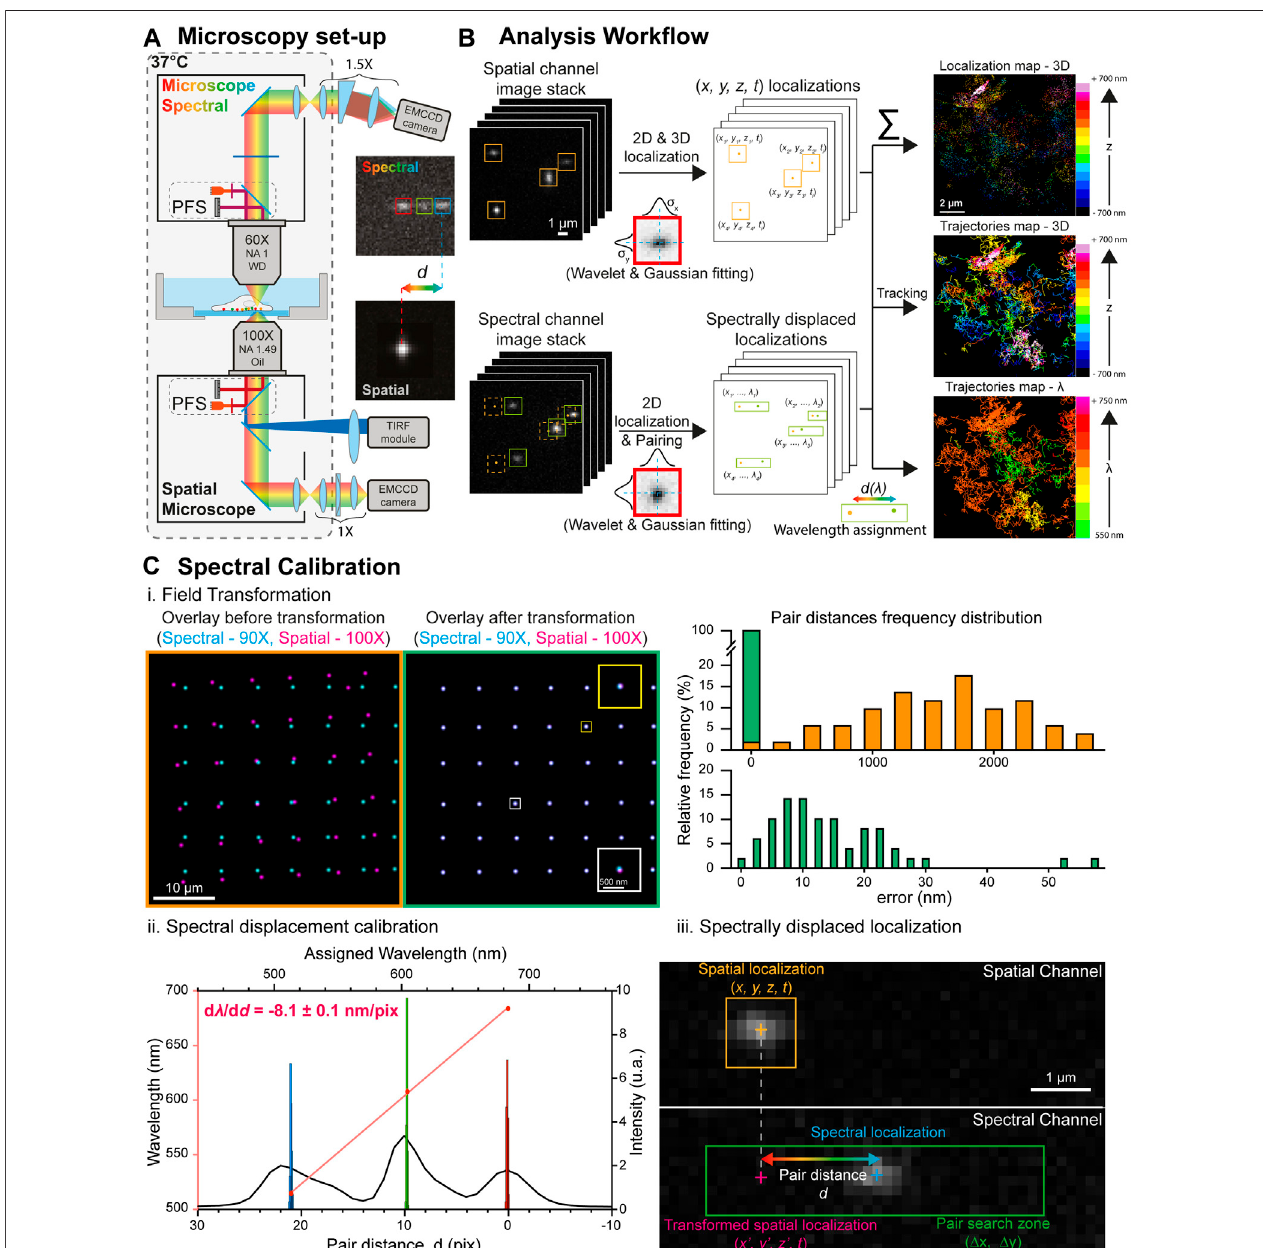
FIGURE 1 | Spectral single molecule microscopy set-up and analysis work fl ow. (A) Microscopy set-up overview: two inverted microscope bodies are positioned oneontopoftheothertobene fi tfromtheirstability,automationandactiveaxialfeedbackthroughtheirrespectivePerfectFocusSystems.Thelower(spatial)microscope is equipped with a TIRF/HILO excitation module and a cylindrical lens for astigmatism-based 3D single molecule localization. The upper (spectral) microscope is equippedwithaspectraldetectionarmmadeofalowdispersiveprism(10 ° )anda×1.5magni fi cationrelaythatconvertsthespectralinformationofsinglemolecules intoaspatialshift d .Theinsetsshow100 nmTetraSpeckbeads(excitedat488,561and642 nm)detectedbythelowermicroscope(bottom)andtheuppermicroscope (top) after dispersion, illustrating the spatial shift induced by the prism according to the emission wavelength. (B) Spectrally displaced localization work fl ow. The single moleculelocalizationsinspatialandspectralimagestacksarecomputedusingwavelet fi lteringandbidimensionalGaussian fi tting.Thelocalizationofthesinglemolecule events in the image stack acquired on the spatial channel enables retrieving their 3D coordinates with nanometric accuracy and reconstruct their trajectories. The spectrallydisplacedlocalization,whichenablestocomputethesinglemolecule ’ sspectralsignature,isperformedbypairingthelocalizationsofthesamesinglemolecule inbothchannelsandcomputingtheirrelativedistance d directlyrelatedtotheemittedwavelength. (C) Spectrallydisplacedlocalizationcalibration. (i.) Left:superposition of the localizations of a bead displaced throughout the cameras whole fi eld of view obtained through the spatial (magenta, ×100 magni fi cation) and spectral (cyan, ×90 magni fi cation)channelsbefore(left)andafter(right)the fi eldtransformation.Theinsetsintherightimagesshowszoomsontwobeadstoillustratethe fi eldtransformation. Right:Histogramsofthedistancesbetweenthepaired spatialandspectrallocalizationsbefore(top)andafter(bottom) fi eldtransformation.After fi eldtransformation, the